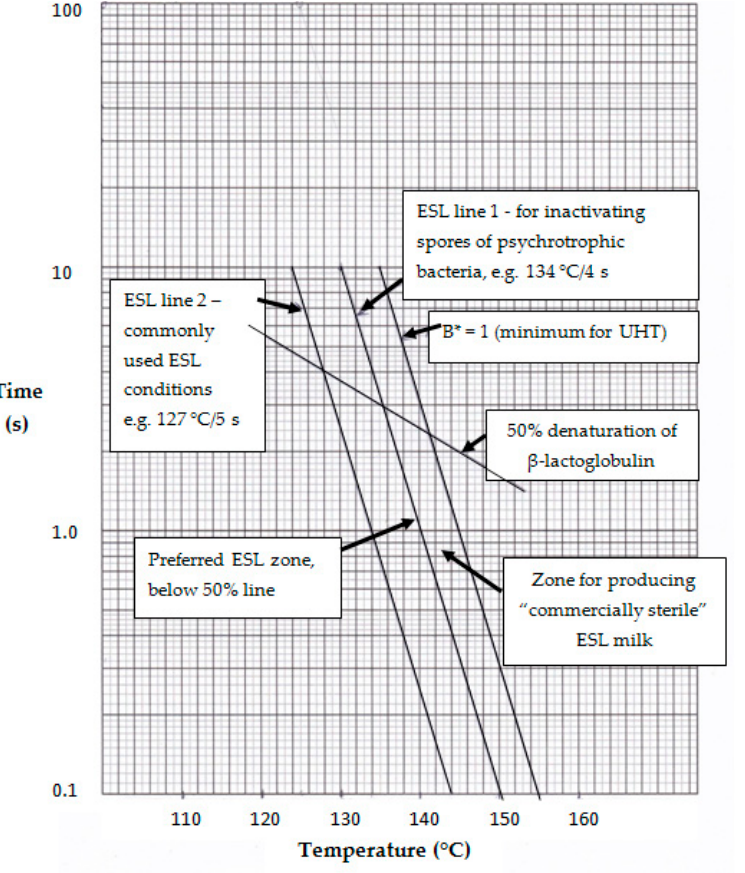
Figure 1. Temperature–time combinations for producing extended shelf life (ESL) and ultra-high-temperature (UHT) processed milk. Points along lines have equal effectiveness in either inactivating bacterial spores or causing 50% denaturation of β -lactoglobulin.